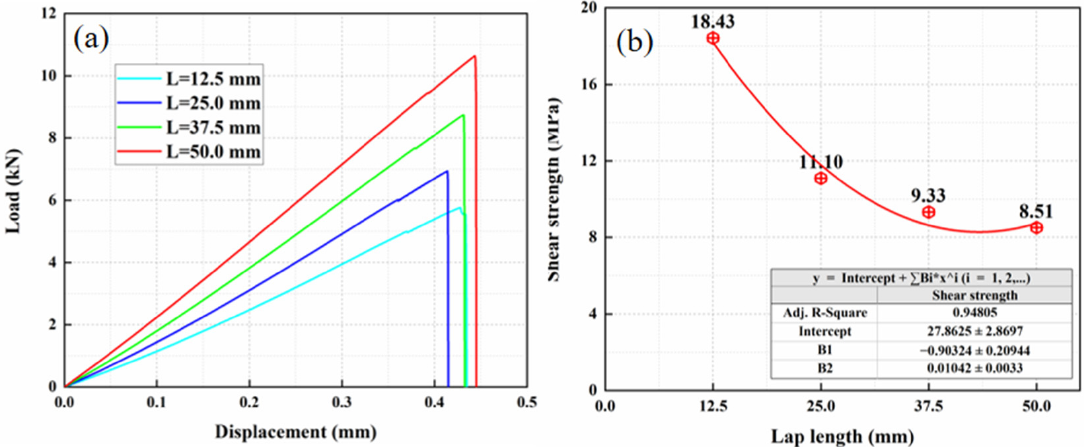
Figure 8. The result of different lap lengths: ( a ) load displacement curves and ( b ) shear strength.